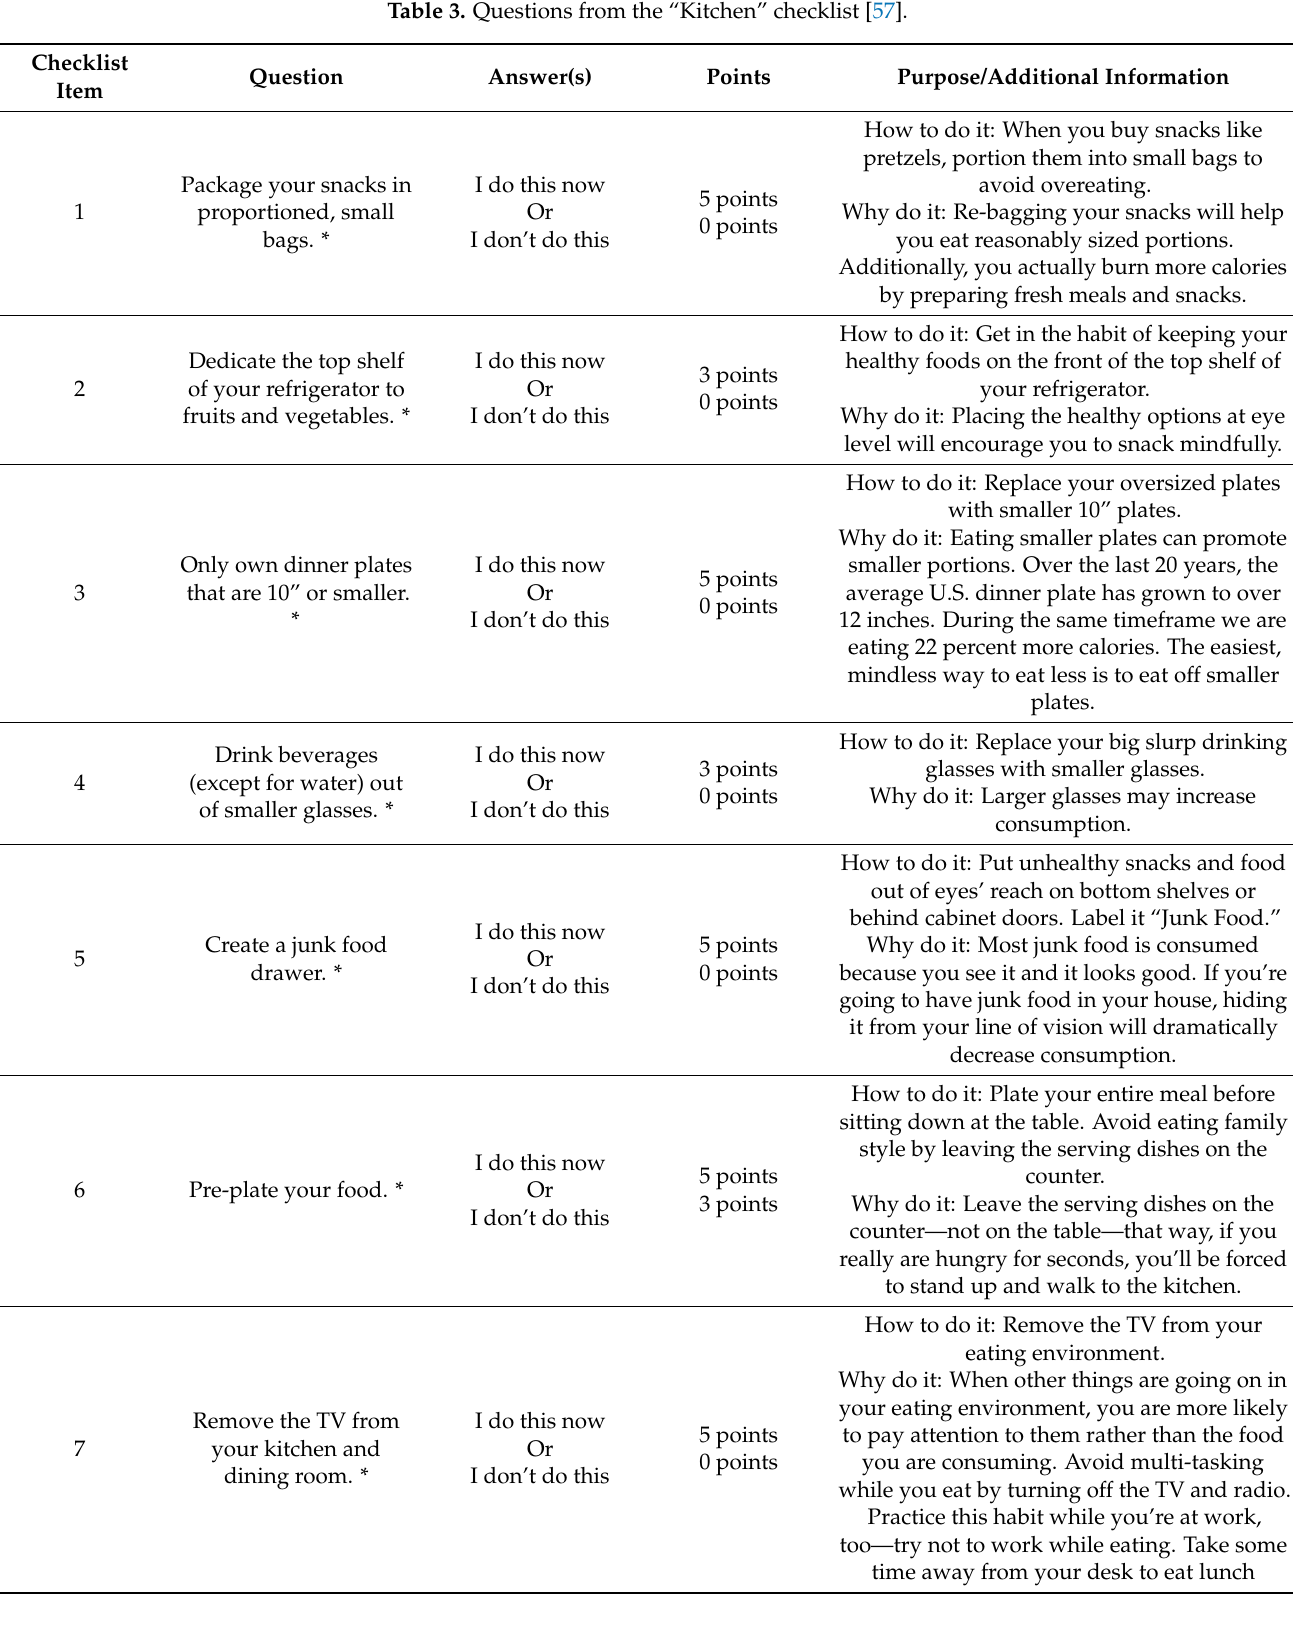
Table 3. Questions from the “Kitchen” checklist